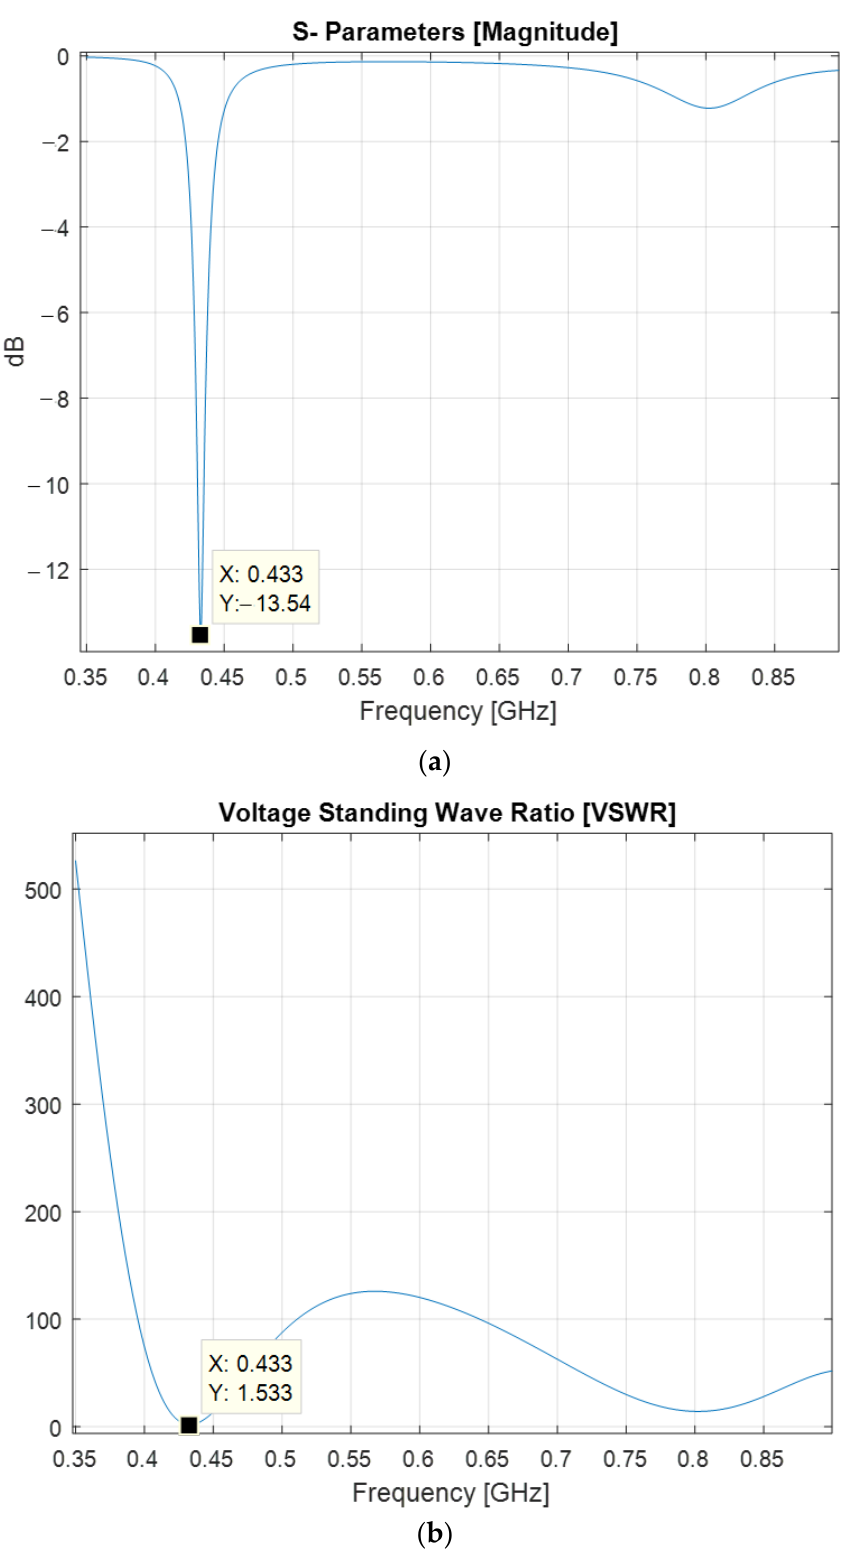
Figure 16. Impedance matching figures at the antenna input with an impedance matching circuit: ( a ) Reflection coefficient; ( b ) Voltage standing wave ratio.